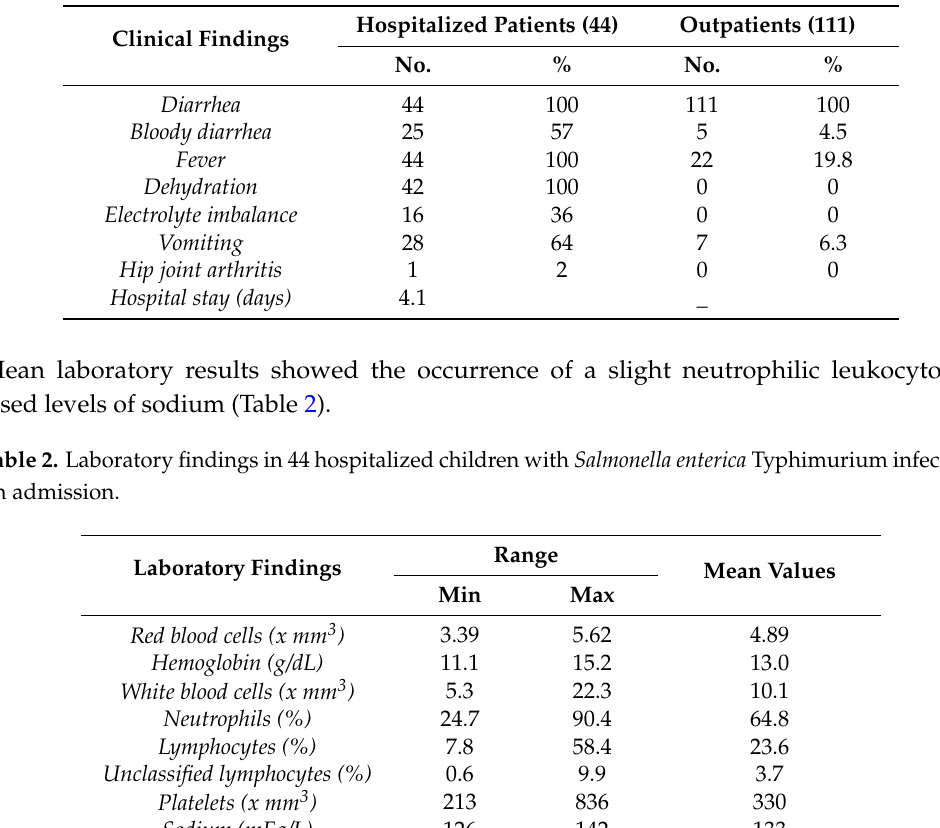
Table 1. Clinical findings in 155 children with Salmonella enterica Typhimurium infection hospitalized or followed up as outpatients.